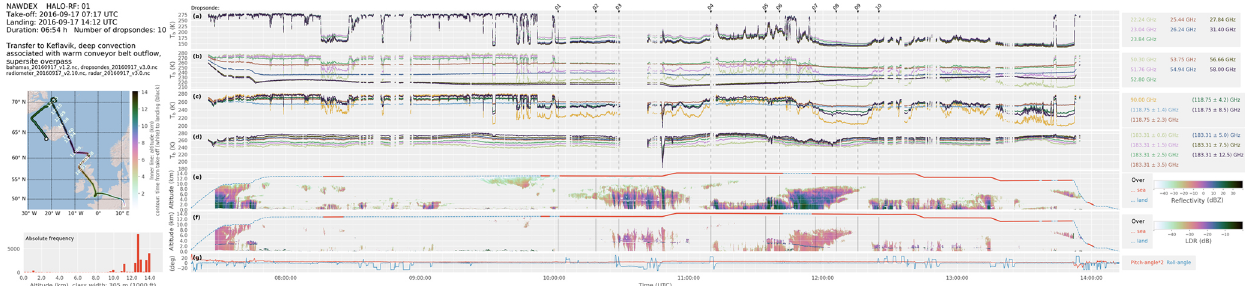
Figure 4. Example of quick look of HAMP measurements that are available along with the data set in the CERA database. Left panel (top to bottom): flight information, flight track and altitude histogram. (a–d) (lines) Microwave radiometer brightness temperatures. (e) (colors) Cloud radar reflectivity. (f) (colors) Cloud radar linear depolarization ratio. (g) (lines) Aircraft attitude. Vertical lines in (a–g) denote times of dropsonde